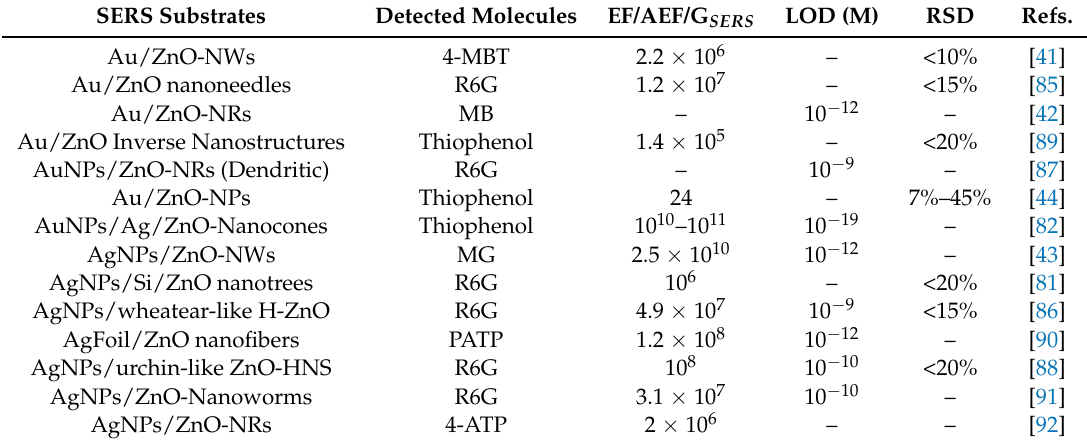
Table 2. SERS performances of metal-coated ZnO nanosystems for chemical sensing.